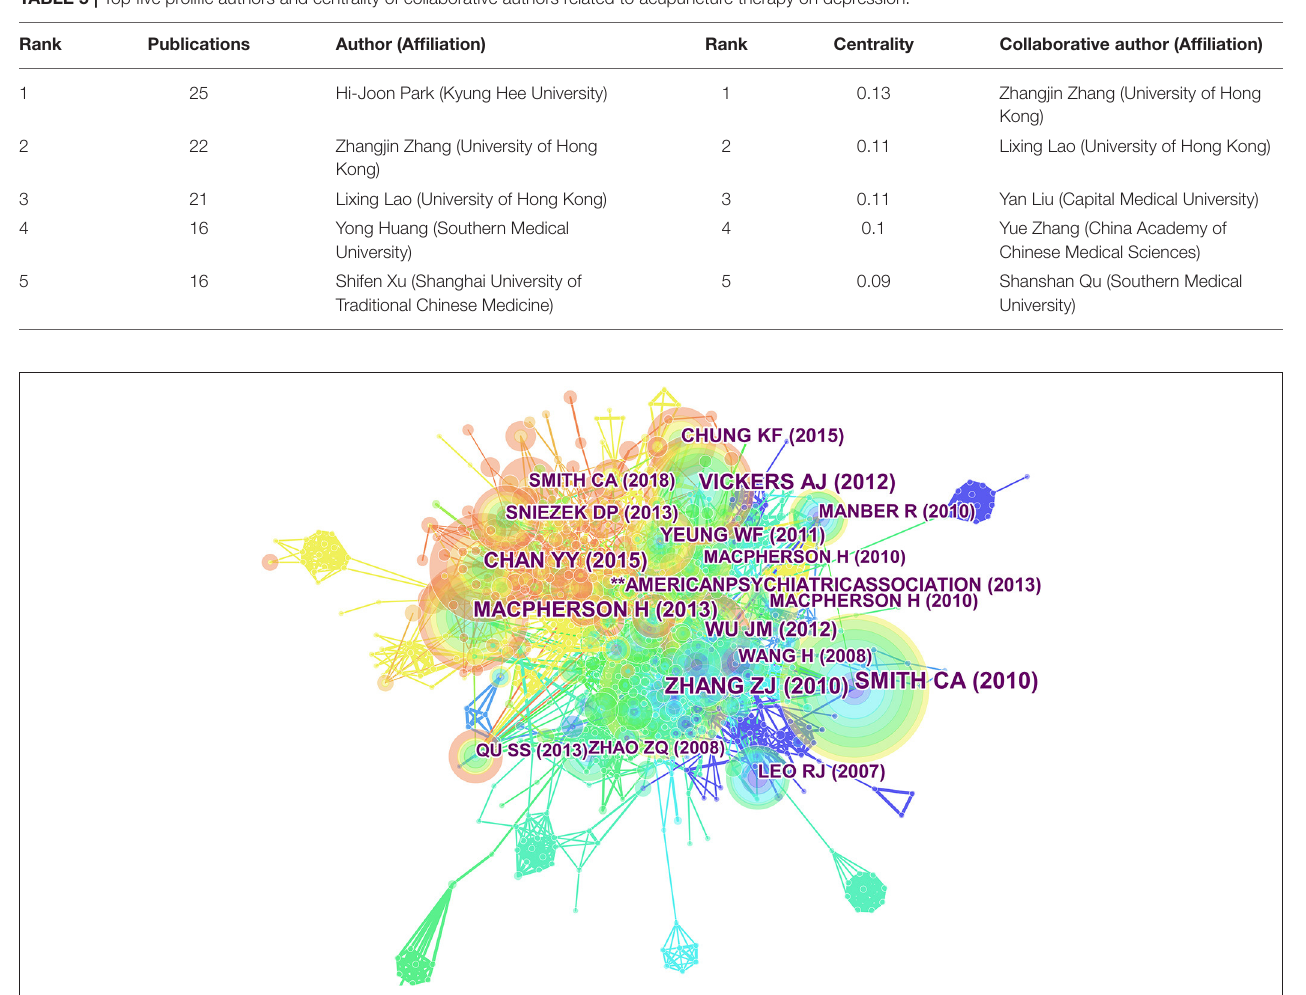
FIGURE 6 | Map of cited references related to acupuncture for depression from 2011 to 2020.